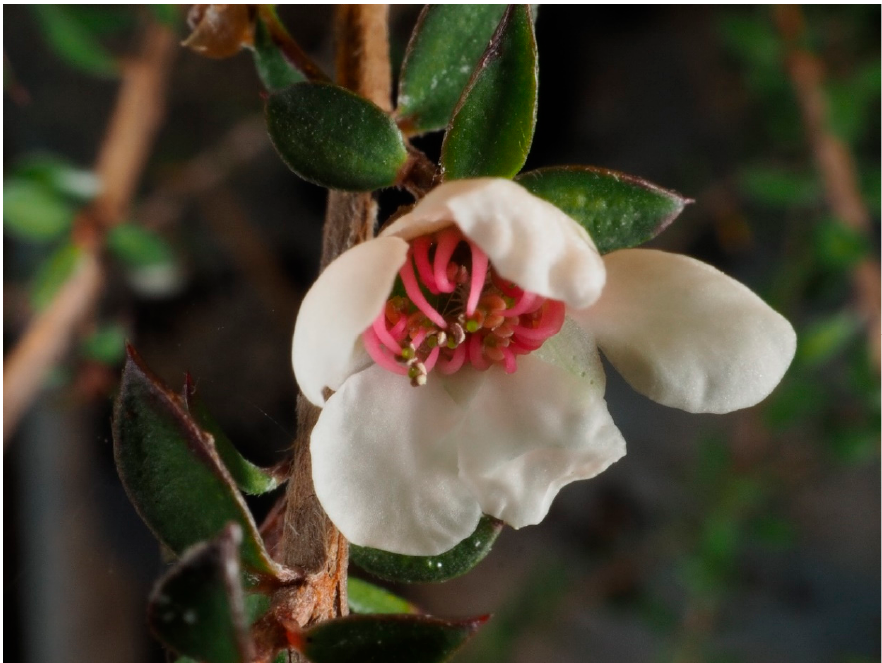
Figure 8. Photo of Leptospermum scoparium J.R.Forst. and G.Forst. (copyright held by Egon Krogsgaard and available under Creative commons licence: Attribution—NonCommercial CC BY NC).